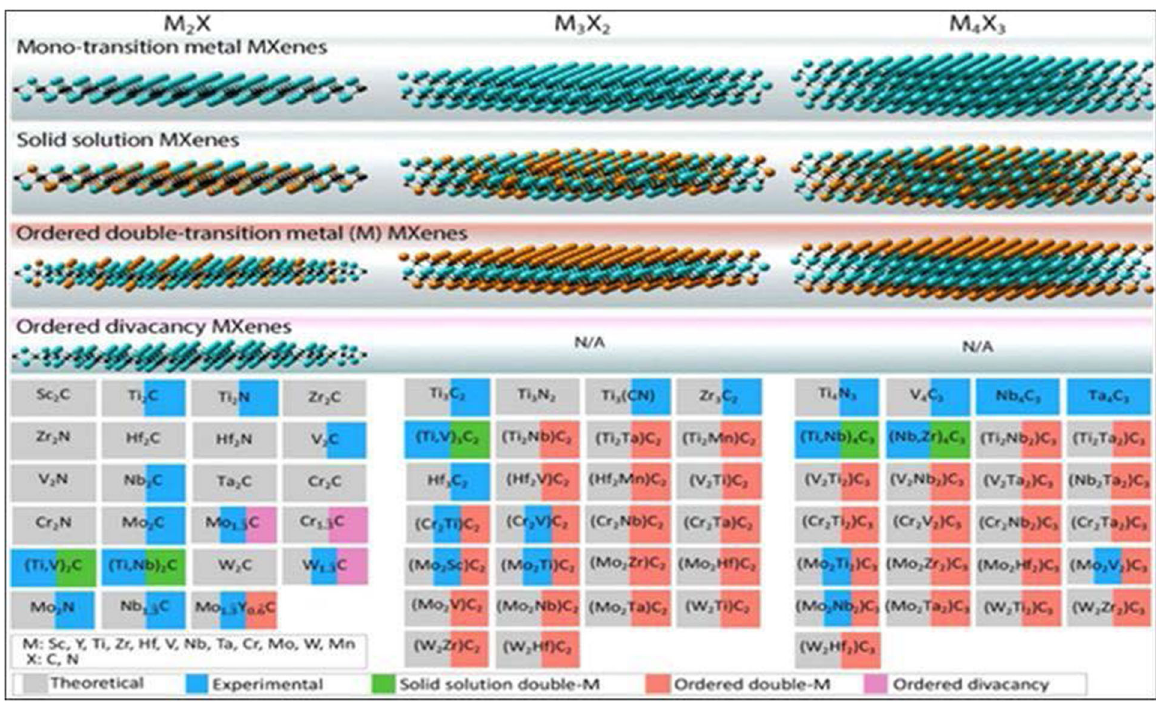
Fig. 1 Different compositions of MXene reported to date. The theoretical (depicted in gray), as well as experimental (depicted in blue) MXenes that have been explored, are included in this table. The top 1st row represents the Mono-M structures of MXenes; the 2nd row represents solid solutions (SS) with Double-M, and their corresponding composition is depicted in green color. The 3rd row represents the ordered Double-M MXenes, and their corresponding compositions are shown in red. The 4th row is an ordered divalent structure, investigated only for M 2 C MXenes, resulting in M1.33 C MXene due to ∼ 33 atomic vacancies in its M layers, and their corresponding compositions are shown in pink. Reprinted with permission from ref. 18